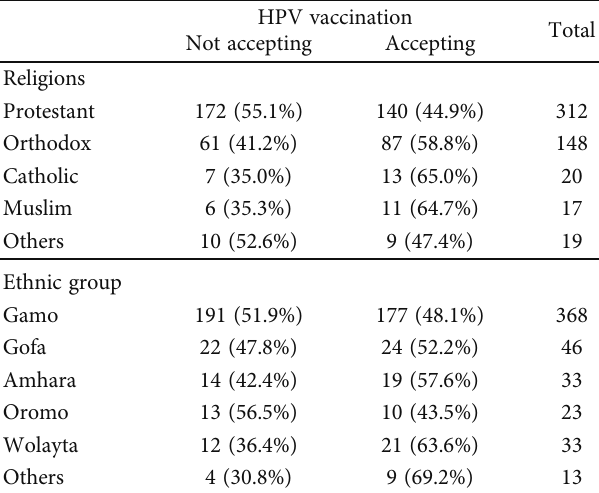
Table 5: The cross-tab result to show the link between religion, ethnic group, and the acceptability of the HPV vaccination among girl students in Arba Minch town, Southern Ethiopia,